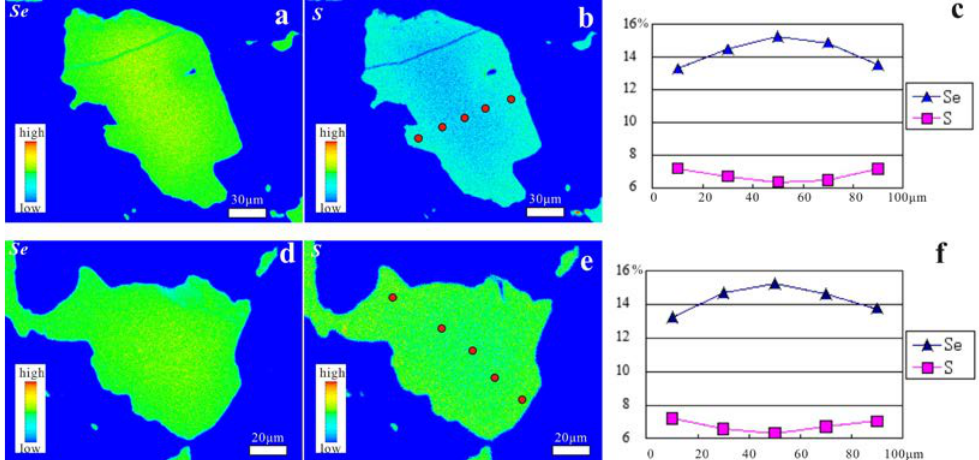
Figure 10. X-ray element-distribution maps for: Se ( a , d ); and S ( b , e ); and EPMA profiles of Se and S ( c , f ) from rim to core of typical selenium metacinnabar grains of the Dongping deposit.